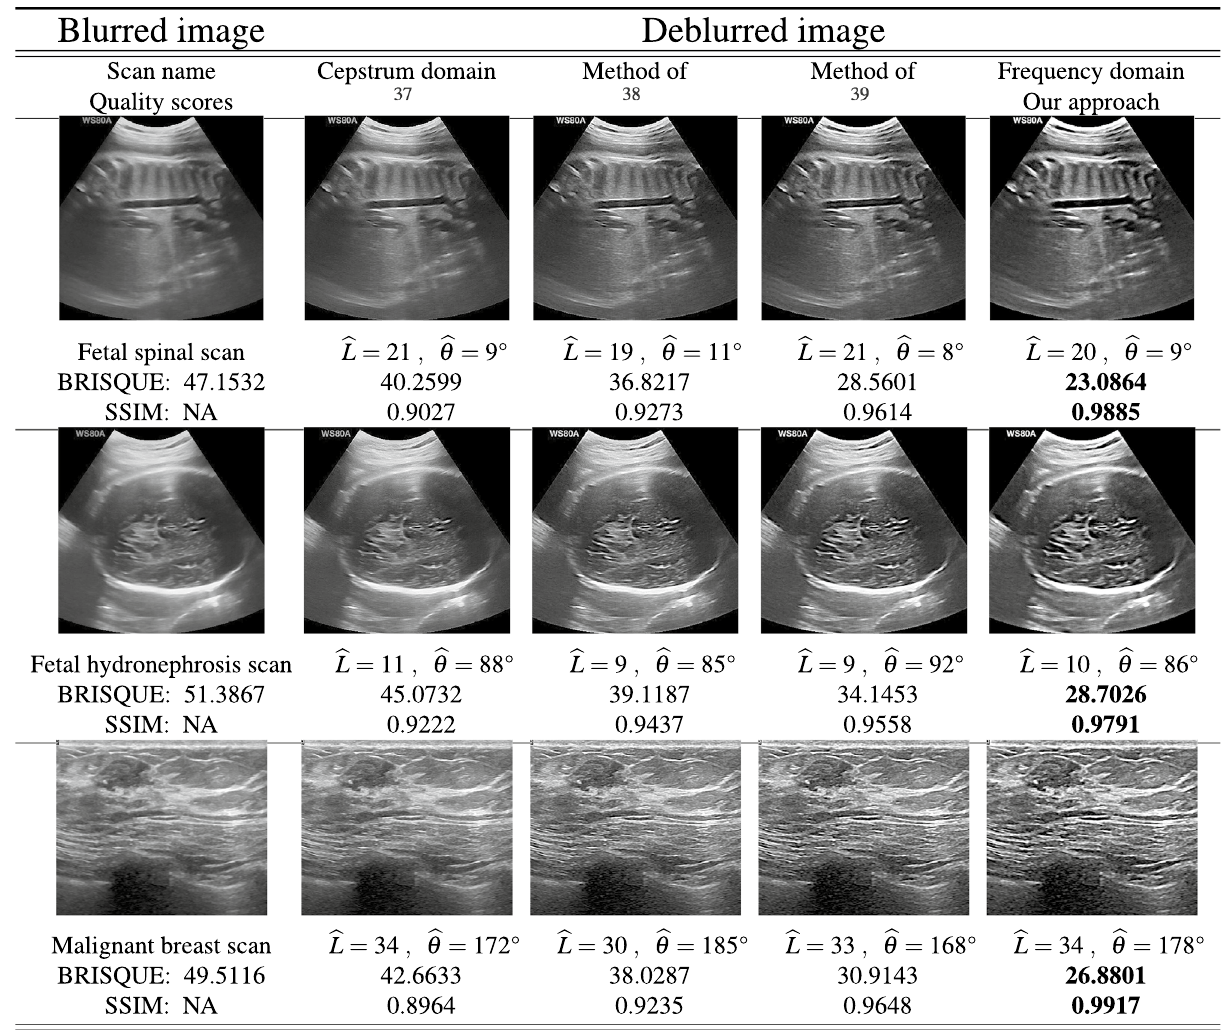
Table 5. Fetal spinal, fetal hydronephrosis and Malignant breast image deblurring using three different methods compared with frequency domain (proposed scheme using estimated motion algorithm) and their corresponding BRISQUE/SSIM